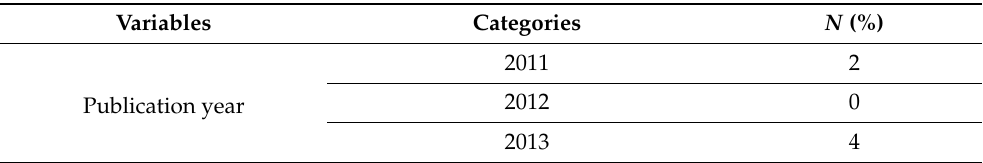
Table 3. General characteristics of the final included studies ( n =